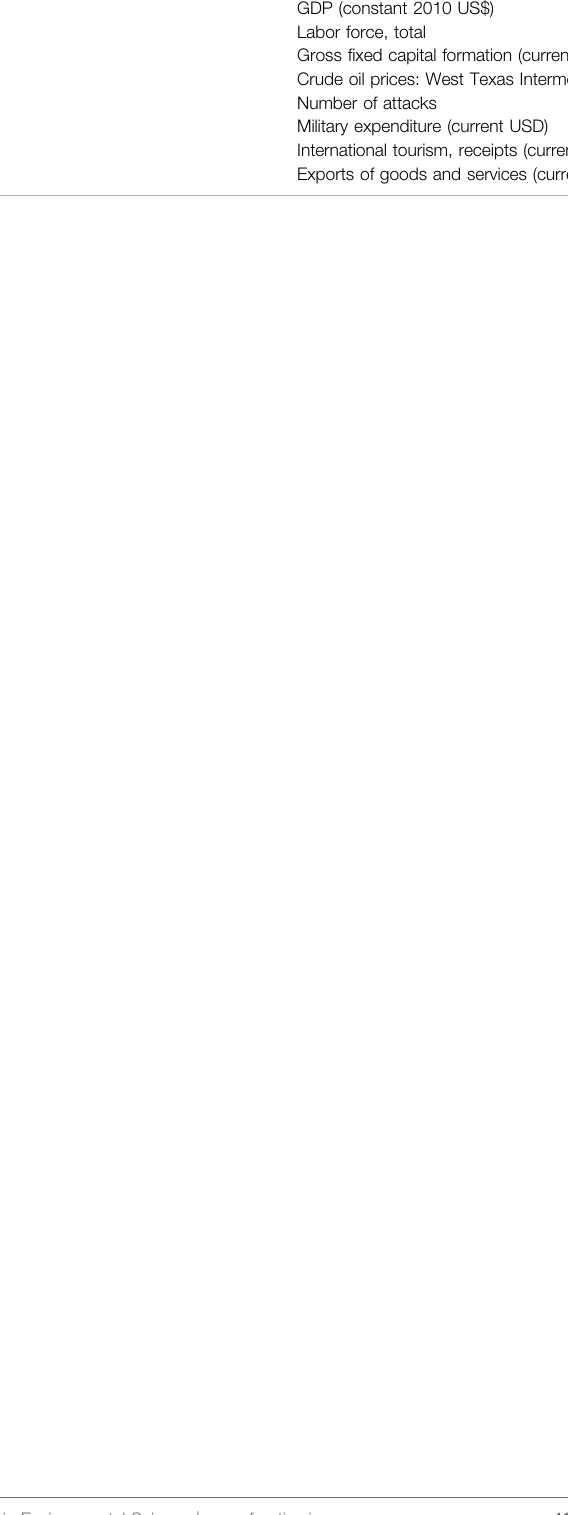
Table A1 | De fi nitions and sources of variables